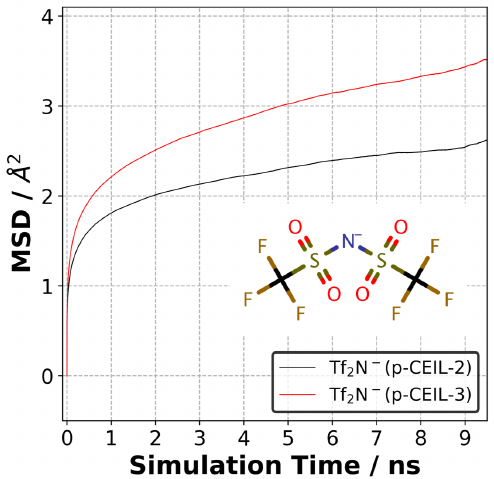
Figure 9. Mean square displacement of anions (Tf 2 N − ) in the p-CEIL-2 and p-CEIL-3 obtained at 27 ◦